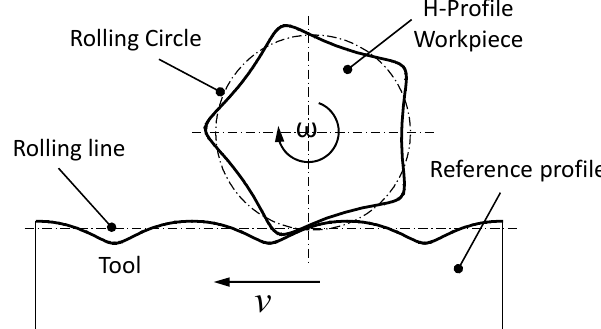
Figure 3. Roller milling manufacturing for H-profile [7].